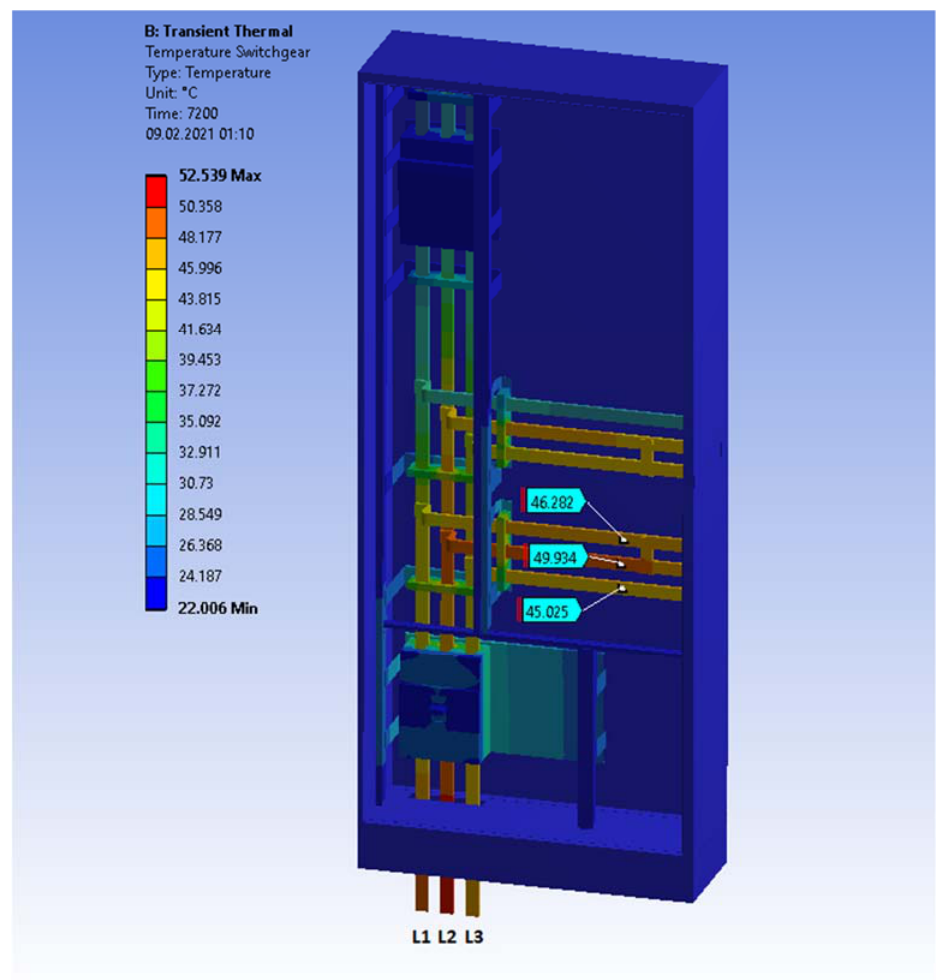
Figure 9. The temperature distribution in busbars and insulators during 7200 s simulation. The above temperature distribution on the insulator ensures that the use of flame- retardant material for support insulators for busbars allows to significantly extending the